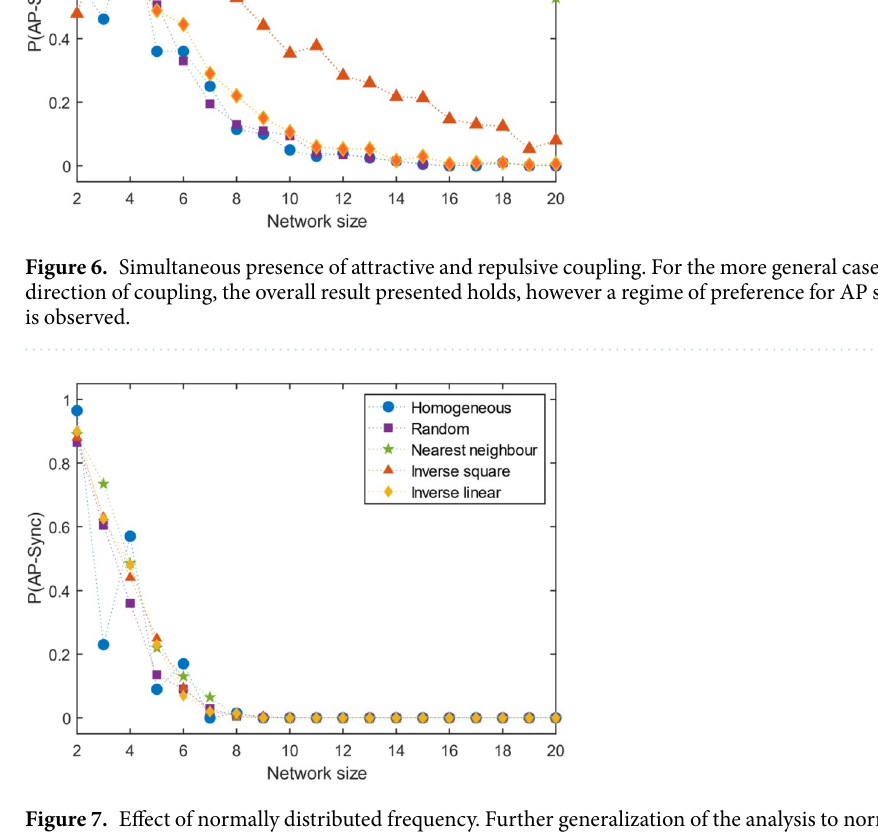
Figure 7. Effect of normally distributed frequency. Further generalization of the analysis to normally distributed frequencies of oscillators reduces the limit at which AP sync can be